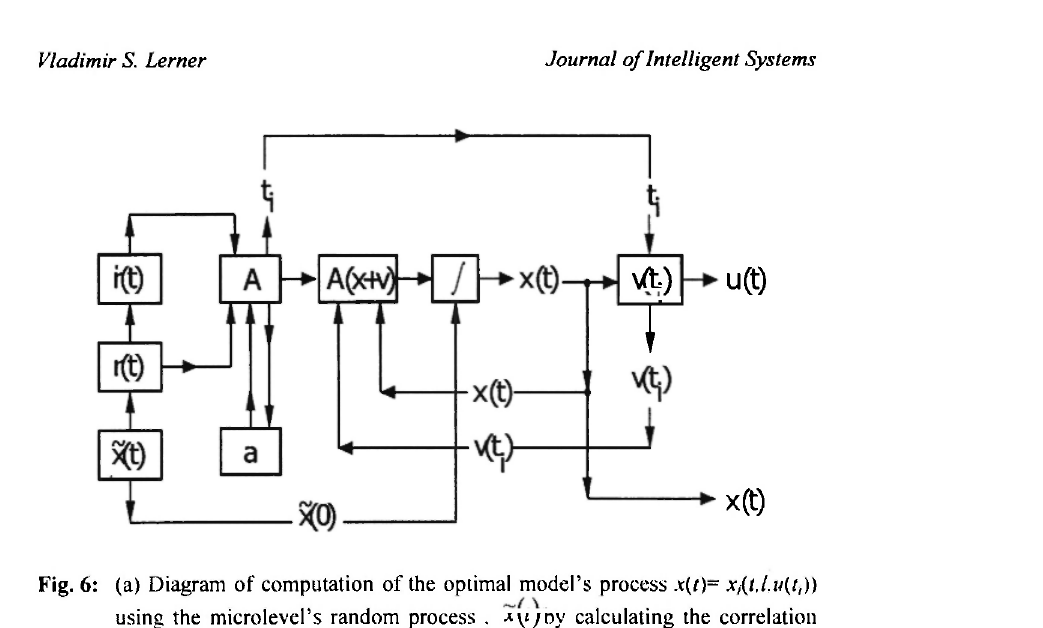
Fig. 6: (a) Diagram of computation of the optimal model's process χ(/)= χ,{I,/,«(«/)) using the microlevel's random process .